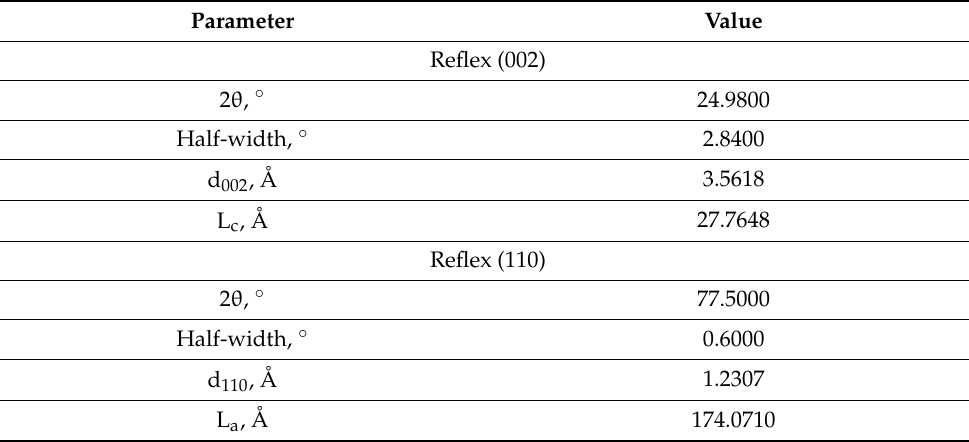
Table 8. The results of diffractometric analysis of the total sediment